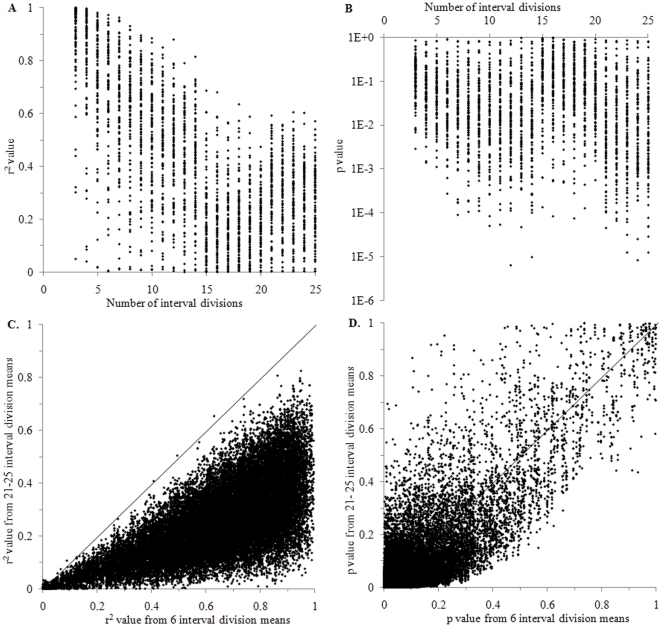
Comparison of r2 and p values from interval means between different numbers of intervals into which time series were divided.A. The number of interval divisions in relation to the resulting r2 value from time regressed against interval means. Data were generated by 100 Monte Carlo simulation runs; total number of data displayed is 2,300. B. Same as (A), but comparing p values instead of r2 values, and with a logarithmic y-axis scale. C. The r2 value from six interval division means compared to r2 values from 20, 21, 22, 23, 24 and 25 interval division means. The diagonal line marks where x-axis and y-axis values are equal. Data were generated by 6,000 Monte Carlo simulation runs; total number of data displayed is 36,000. D. Same as (C) but comparing p values instead of r2 values.